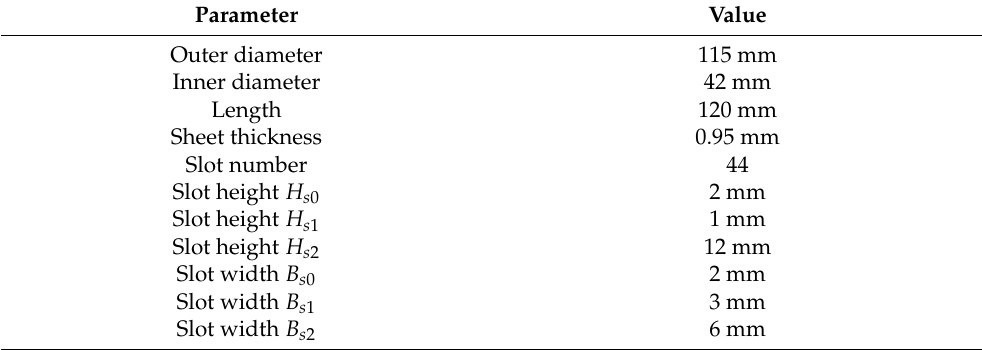
Table 4. Rotor dimensions of the IM.